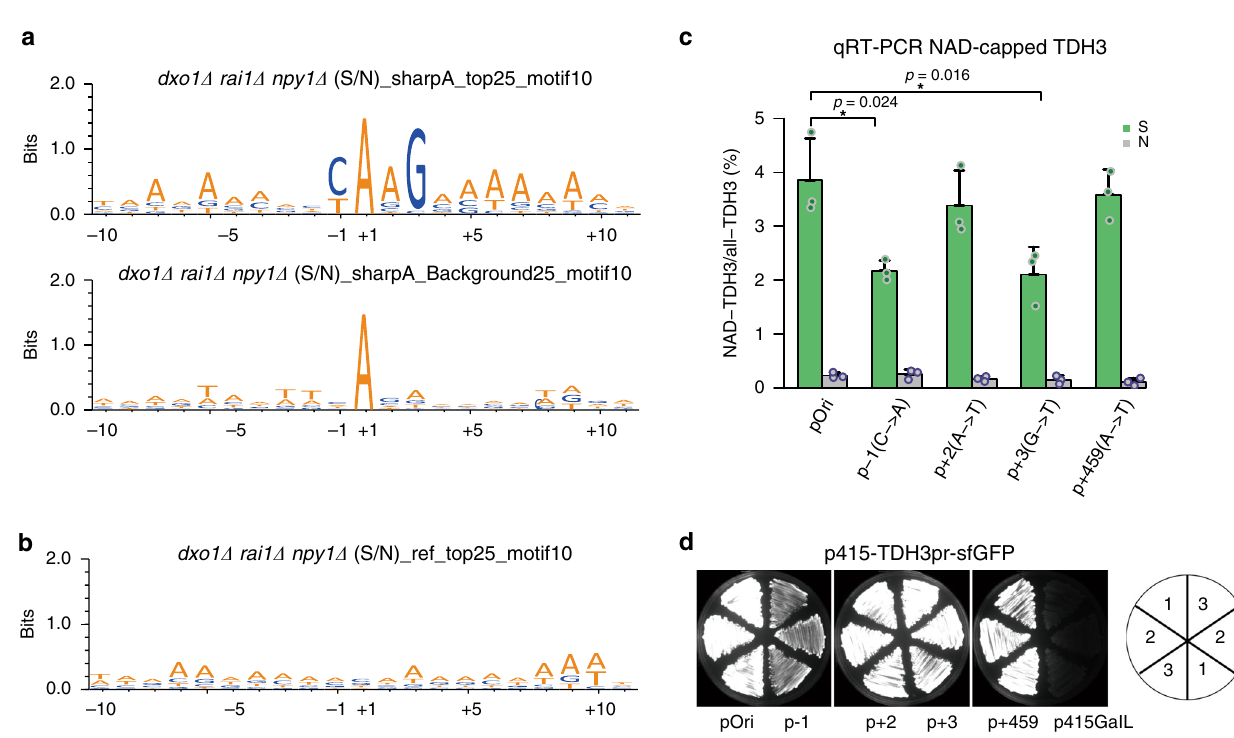
Fig. 7 NAD incorporation by RNAP II is promoter dependent. a Motif analysis of the − 10 to + 10 region around the TSS based on NAD captureSeq data. Top25 and background25 represent the 25 NAD-mRNA species with the highest enrichment values and the 25 most abundant, but not signi fi cantly enriched mRNA species (0.707 ≤ S/N ≤ 1.414) with a sharp A feature at position + 1 (TSS) in the dxo1 Δ rai1 Δ npy1 Δ strain. S/N is the enrichment of NAD- RNA in the sample group ( + ADPRC) compared to the negative control group ( − ADPRC). Sharp A means an “ A ” at position + 1 with a more than three-fold higher signal than that of the nucleotide in the − 1 position. The letters, representing the four nucleobases, were colored dark orange for A/T and blue for G/C. b Motif analysis of the same Top25 enriched RNA species, using the canonical TSS from Nagalakshmi dataset 18 . c Quanti fi cation of the NAD- modi fi cation ratio using the TDH3 gene promoter and the relevant mutant promoter sequences in vivo. The height of the green bar indicates the TDH3 RNA NAD-modi fi cation ratio in the sample group ( + ADPRC), whereas the gray bar denotes the same in the N group ( − ADPRC). The pOri represents the original TDH3 promoter and promoter mutants are enumerated below the bar chart. Dots represent biological triplicates and error bars represent SDs. p -values are denoted by asterisks: * p < 0.05 (Student ’ s t -test, one sided). d Expression of sfGFP under a TDH3 gene promoter or relevant promoter mutants in vivo. pOri, p − 1, p + 2, p + 3, and p + 459 are the same as in Fig. 7c. p415GalL is negative control strain for background. All strains were cultured in biological triplicates, n = 3. Source data are provided as a Source Data fi